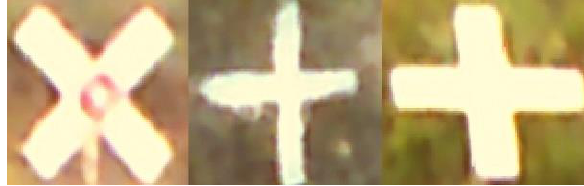
Figure 2. Photogrammetric targeting of ground control points on scanned Rollei 6006 metric images.